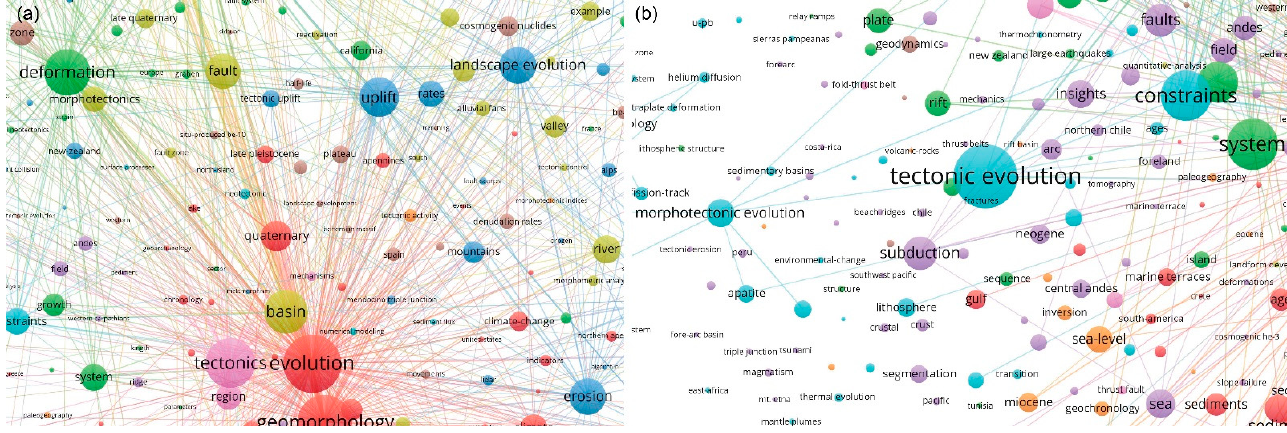
Figure 7. ( a ) Links of keywords “Evolution” and “Deformation” zoomed in Figure 6 from 1981 to 2021, ( b ) Links of keywords “Tectonic evolution” zoomed in Figure 6 from 1981 to 2021.